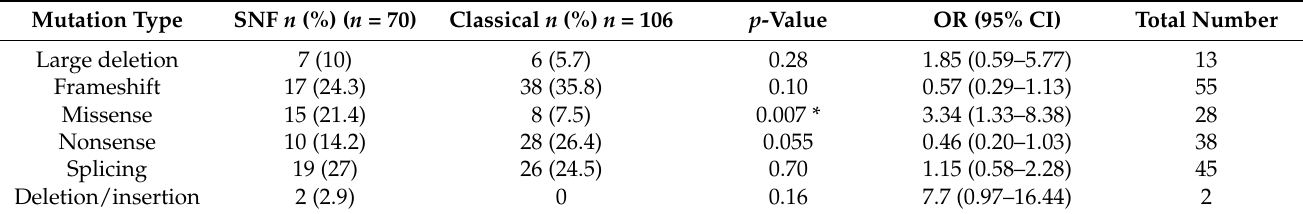
Table 6. Distribution of the NF1 pathogenic variant types between the SNF and classical